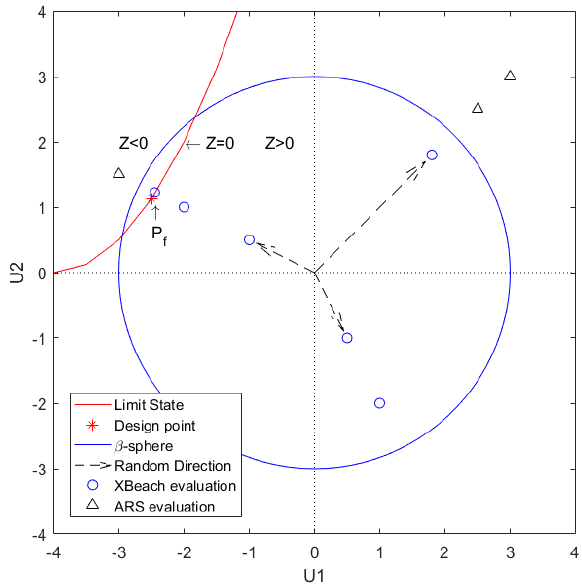
Figure 3. A schematized and arbitrary example of the ADIS method, with two stochastic variables (U1 and U2). The standard normal space is given, together with the limit state (red line), the design point (red asterisk), β -sphere (blue circle), random directions (dashed arrows) and XBeach and ARS evaluations (blue circles and black triangles). The areas where Z < 0 and Z > 0 and the limit state Z = 0 are indicated as well (after Den Bieman et al.; Grooteman [21,36]).